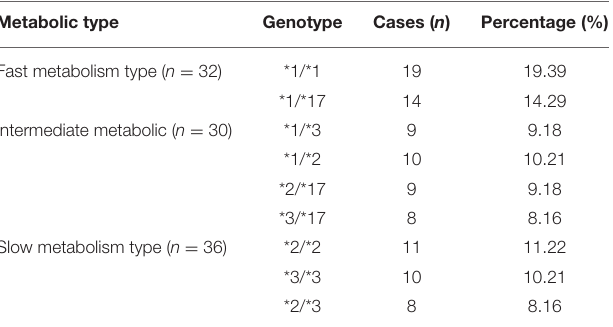
TABLE 2 | Grouping and distribution of CYP2C19 genotype in the observation group.